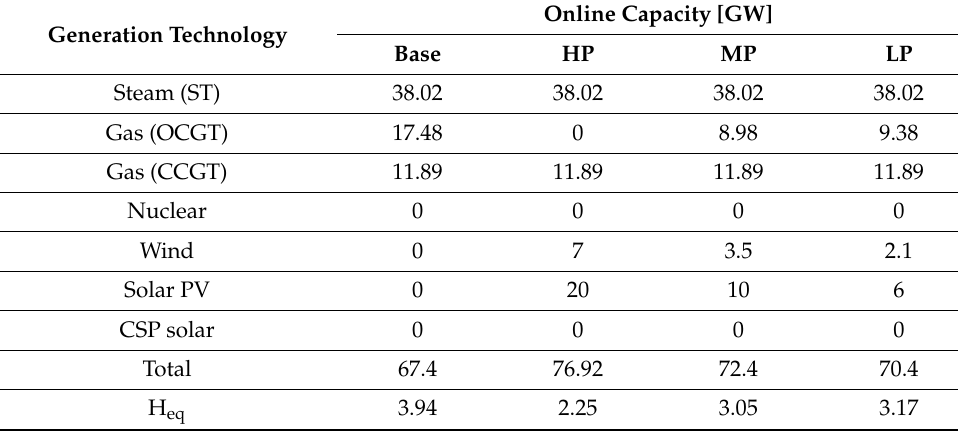
Table 6. Online generation under base load conditions in 2023.